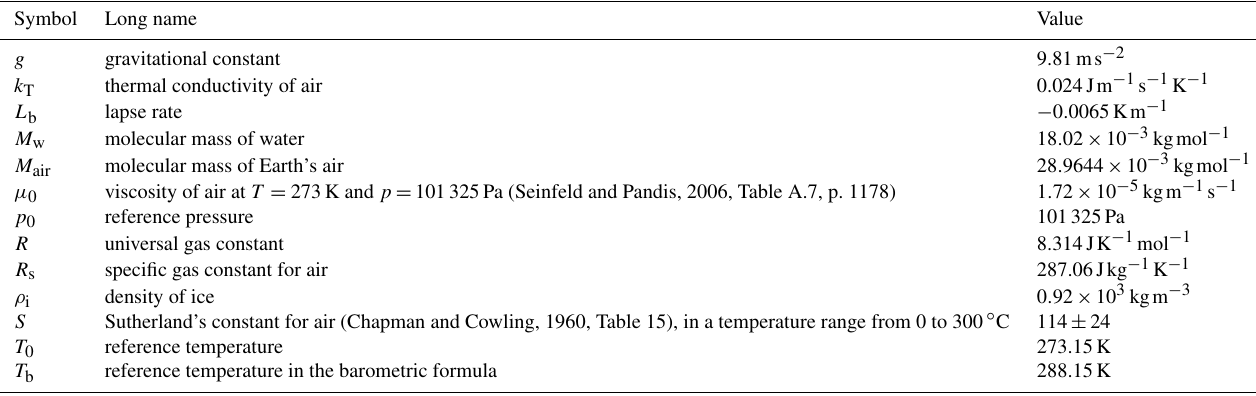
Table A3. Equations used in the sublimation calculations for a hexagonal plate. The other equations used are the same as for a sphere and are given in the text. Equation for hexagonal plates Replaces Eq.